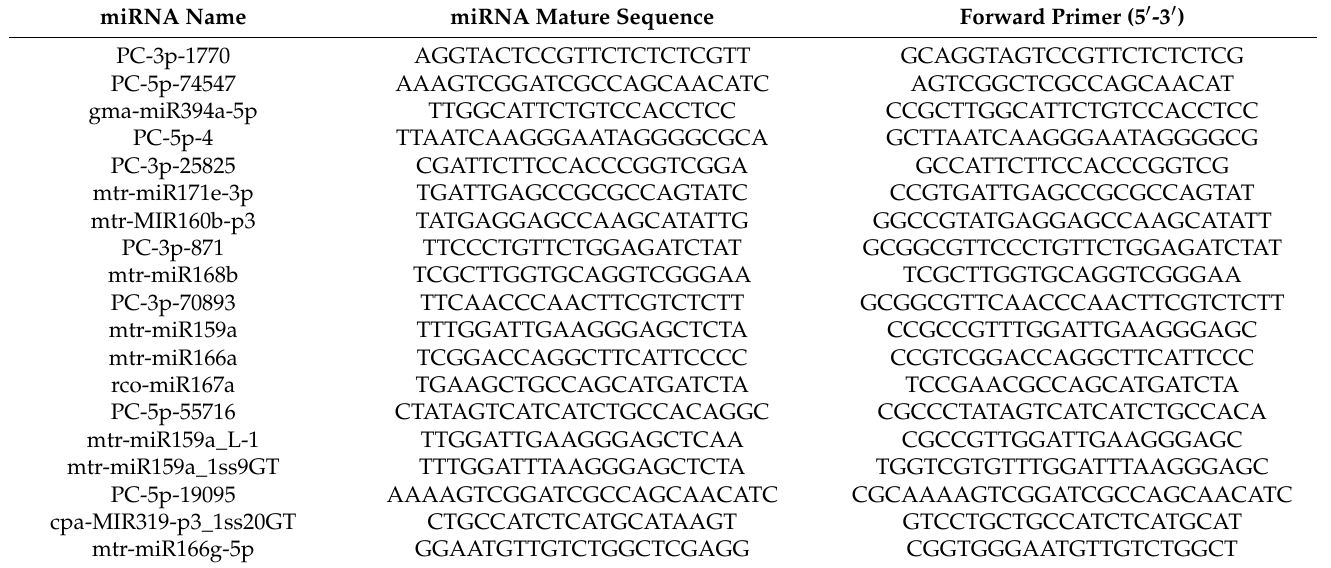
Table 1. Sequences and forward primer sequences of candidate reference miRNAs for